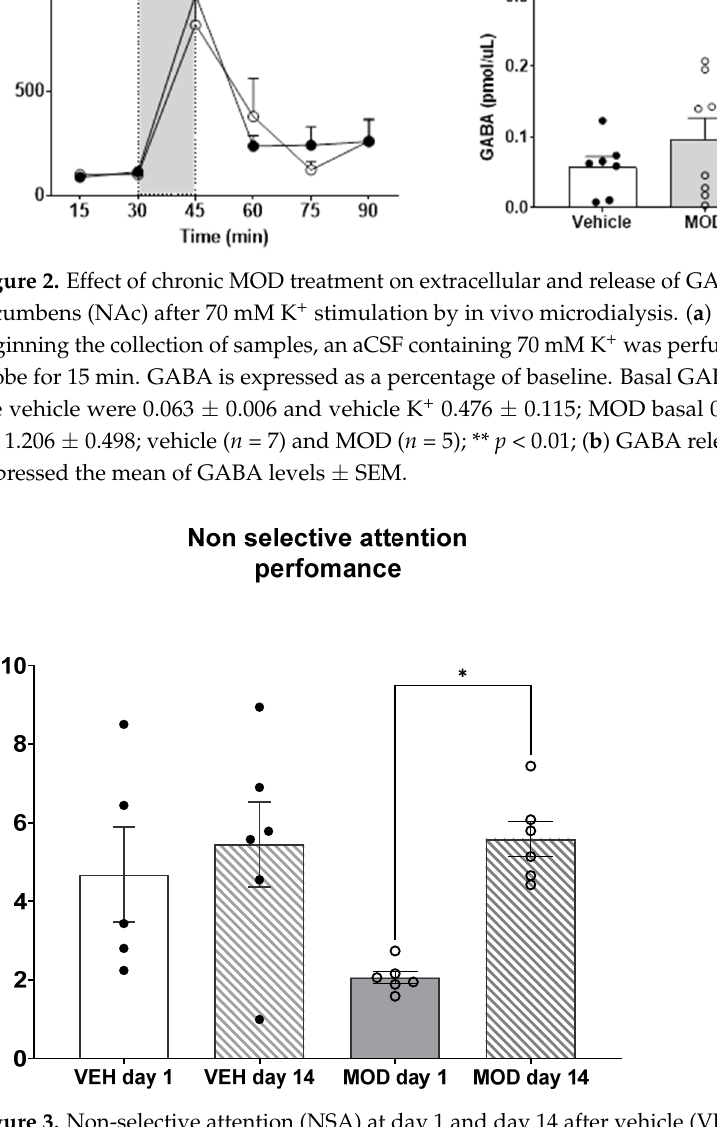
rank 1 = 3.80, mean rank 2 = 11.33, mean rank difference = − 7.533, Z = 1.83; p =